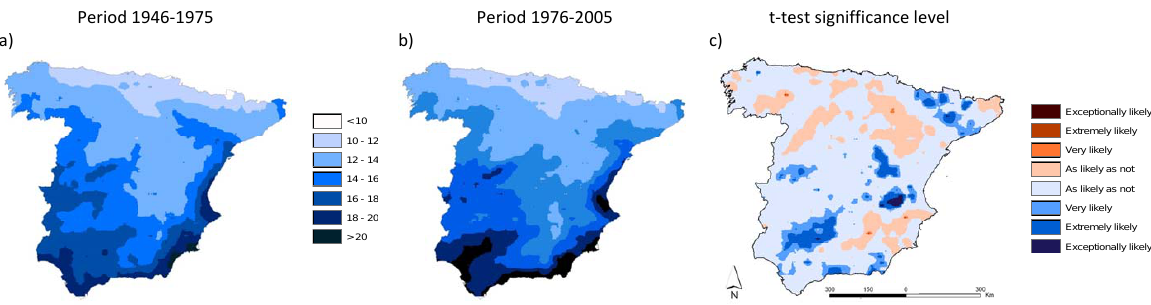
Fig. 1. Mean value of the Precipitation Concentration Index (annual scale) during the periods: (a) 1945–1975 and (b) 1976–2005. (c) Changes between periods according to different levels of probability categorized as follow: exceptionally likely ( p < 0 . 01); extremely